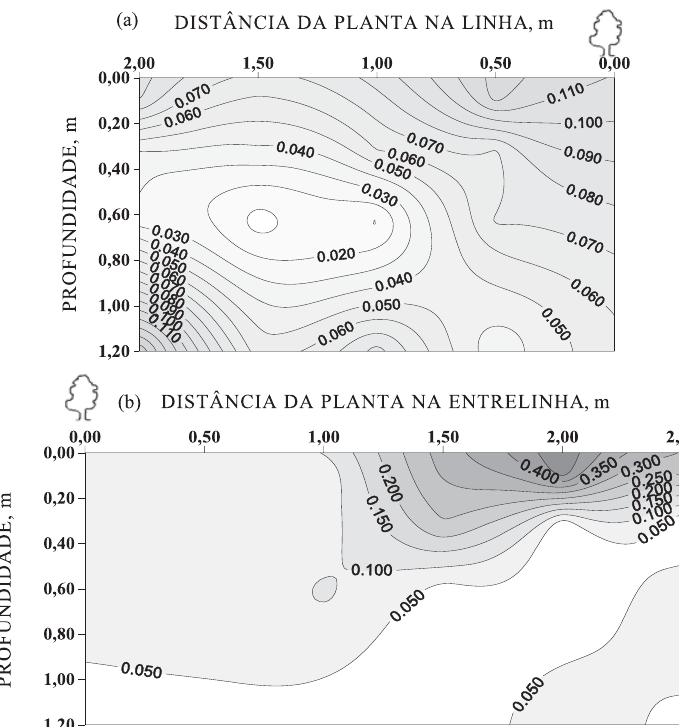
Figura 4. Distribuição espacial da densidade total de raízes da laranjeira ‘Hamlin’ enxertada em limoeiro ‘Cravo”, em cm de raízes por cm -3 de solo, no perfil de um Latossolo Amarelo Argissólico (LAx) coeso, em uma toposseqüência de solos de tabuleiro localizada em Sapeaçu (BA), (a) na linha e (b) na entrelinha.